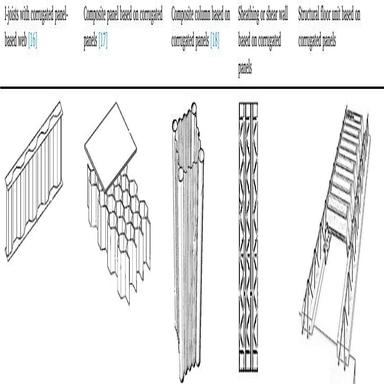
Wood-based I-joists with 5 mm, corrugated, veneer-waste web elements.